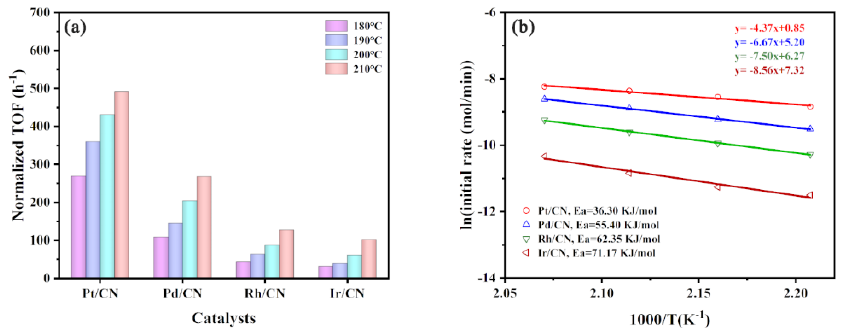
Figure 6. ( a ) TOF values at 180 – 210 °C and ( b ) Arrhenius plots of cyclohexane dehydrogenation.